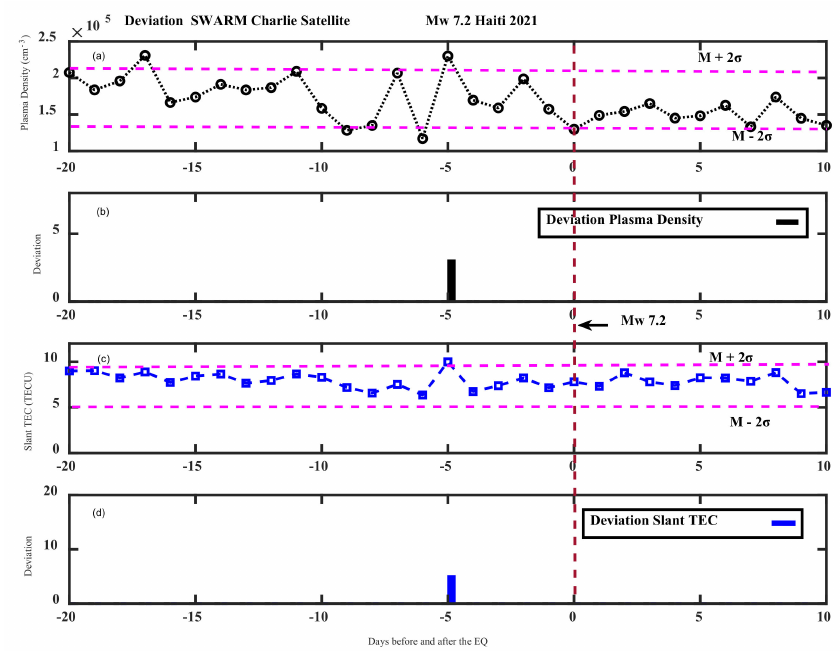
Figure 11. ( a ) plasma density, ( b ) deviation of plasma density from upper and lower bounds of mean and standard deviation as an anomaly, ( c ) STEC, and ( d ) deviation of STEC from upper and lower bounds of mean and standard deviation as an anomaly from Swarm-C for M w 7.2 (Haiti). The red dashed line represents the EQ